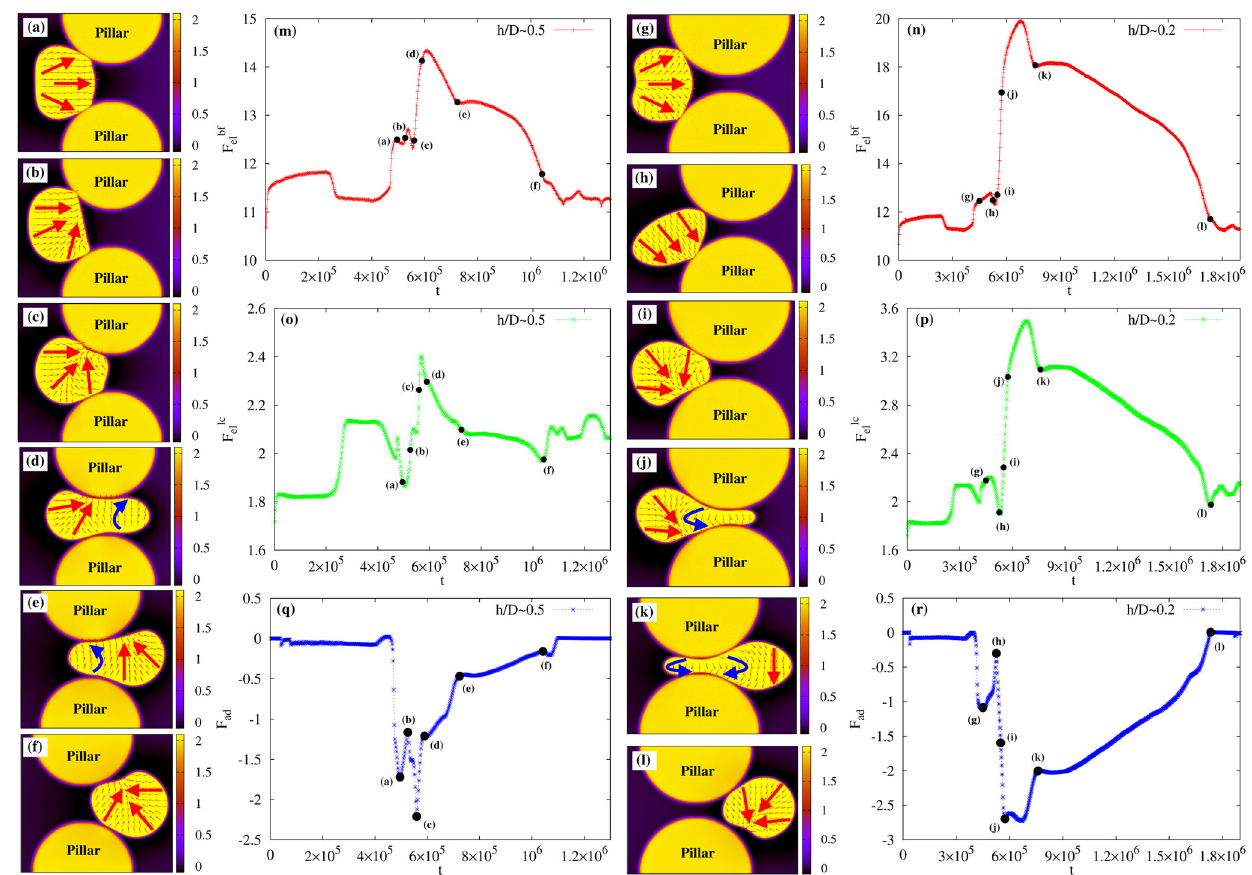
Fig. 6 | Free energy. The plots show the time evolution of the elastic free energy R k = 2 ð ∇ ϕ Þ 2 of the binary fl uid (top line, red pluses), the elastic free energy F bf R 1 el = F lc κ = 2 ð ∇ P Þ 2 of the polar liquid crystal (green, crosses), and the adhesion con- el = tribution F ad = ∫∑ i , j , i < j γ ∇ ϕ i ∇ ϕ j (blue, asterisks). Black dots indicate the instanta- neouscon fi gurationsoftheactivedropletduringthetransmigrationfor λ ≃ 0.5(left side) and λ ≃ 0.2 (right side). If λ ≃ 0.5, the droplet adheres to pillars and